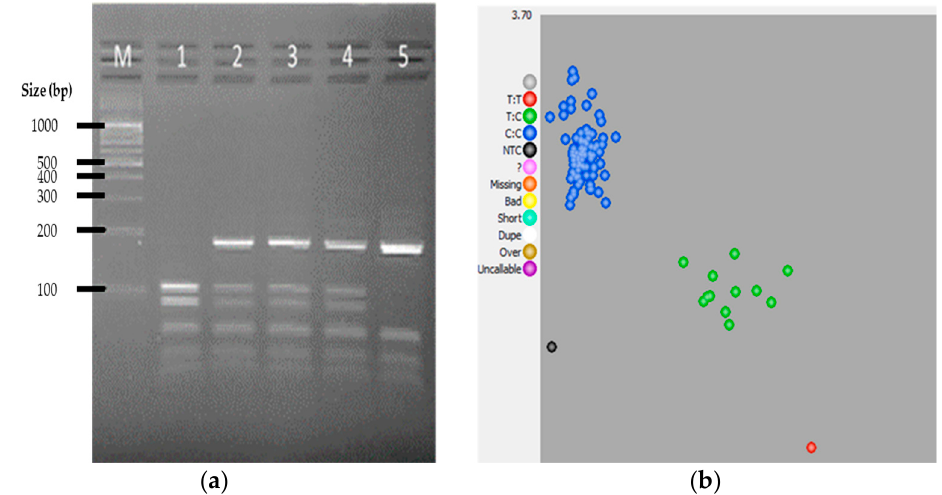
Figure 4. Representative results for DRD4 (2) gene SNP genotyping by PCR-RFLP and KASP assays. ( a ) Agarose gel electrophoretic profile of selected samples showing the banding patterns for the CC allele (lane 1), TC allele (lanes 2, 3, and 4), and TT allele (lane 5). ( b ) Cluster plot for the KASP genotyping assay: TT allele (red cluster), TC allele (green cluster), and CC allele (blue cluster). Table 3. Summary of results for the genotype obtained using PCR-RFLP and KASP. Gene